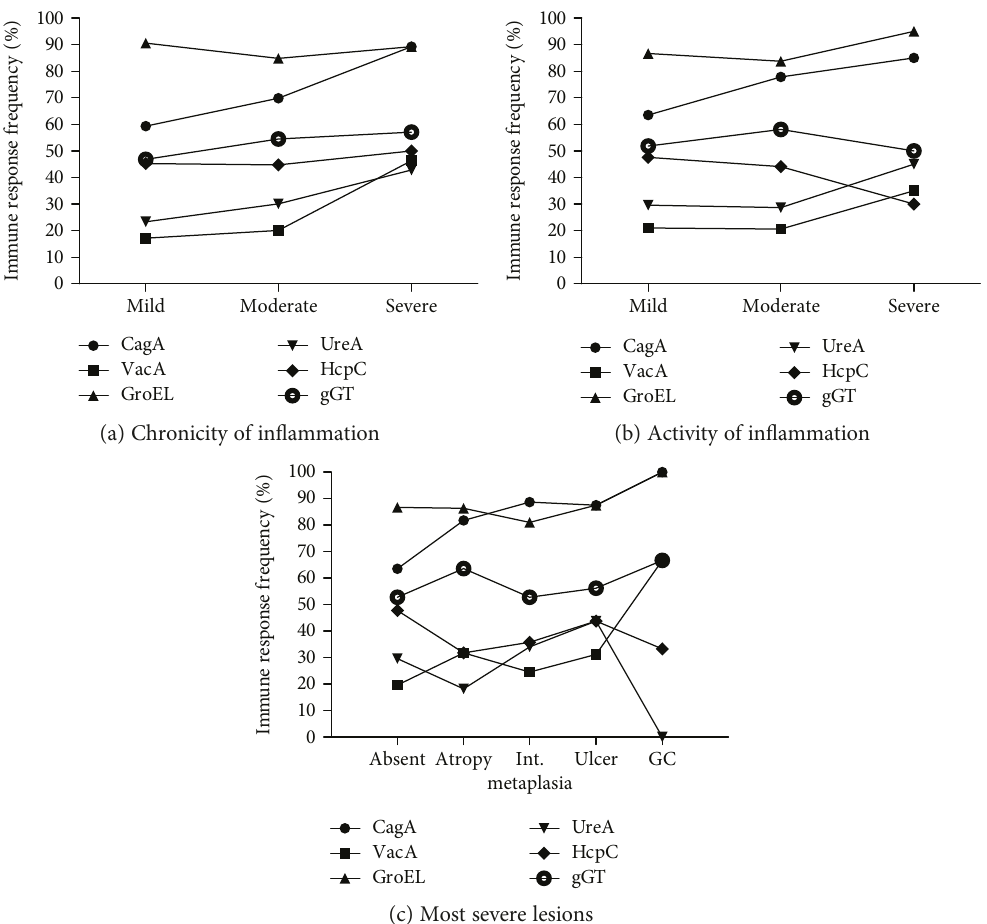
Figure 3: Association between positivity of individual antigens ( ● CagA, ■ VacA, ▲ GroEL, ▼ UreA, ♦ HcpC, and ○ gGT) and histologic fi ndings such as (a) chronicity and (b) activity of in fl ammation as well as (c) most severe lesions. The chronicity and activity are categorized as mild, moderate, and severe. Most severe lesions are categorized as either absent, atrophy, intestinal metaplasia, ulcer, or gastric cancer (GC) according to histology. A signi fi cant correlation could be found between CagA or VacA and the chronicity of in fl ammation ( p = 0 015 ; p < 0 01 , resp.), as well as CagA and the activity of in fl ammation ( p < 0 01